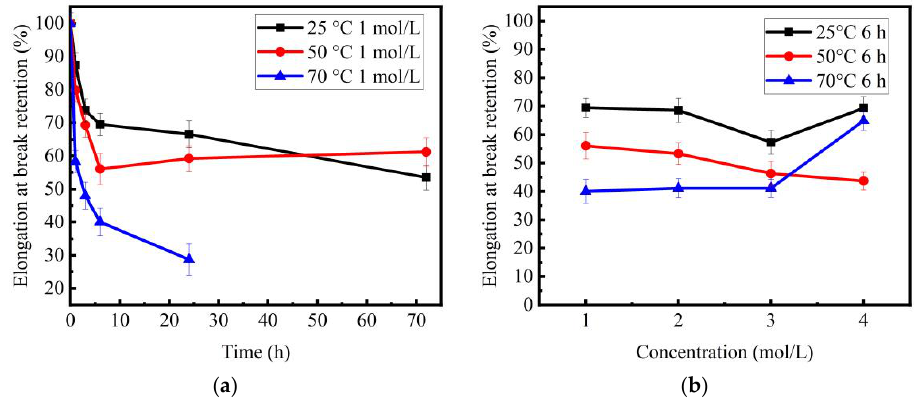
Figure 4. Elongation at break retention ratios of basalt fibers after NaOH solution treatment: ( a ) elongation at break retention ratios vs. corrosion time; ( b ) elongation at break retention ratios vs. concentration with 6 h immersion.